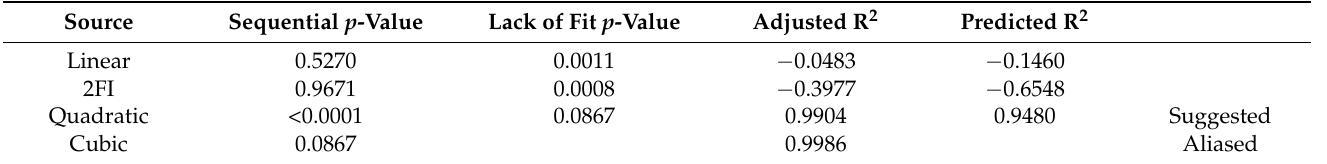
Table 3. Fit summary for %COD removed.